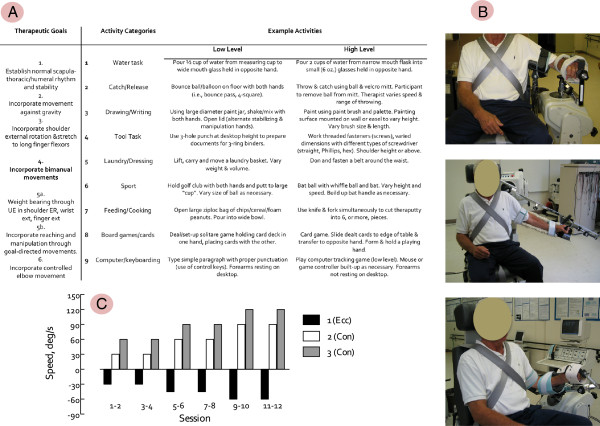
Therapeutic interventions. The therapeutic interventions used in this study included functional task practice (FTP) and upper-extremity power training combined with FTP (HYBRID). The structure of the FTP program is outlined in Panel A with examples of how activities were identified for study participants of varying abilities and progressed over the course of the intervention. Power training was delivered using a commercially available dynamometer fitted with custom attachments to enable non-standard positioning and accommodate individuals with impaired grasp. Pictured in Panel B are configurations for elbow flexion/extension (top), shoulder abduction (middle) and shoulder external rotation. The elbow flexion/extension configuration was also used for stretch reflex testing. Power training involved 3 sets of 10 repetitions of each exercise: shoulder flexion, shoulder abduction, shoulder external rotation, elbow flexion/extension. The criterion speeds for each set were varied using the protocol illustrated in Panel C. The first set of each exercise involved eccentric actions in which the participant resisted the dynamometer through the full range of motion. Using data reported by Colsen et al
[30] (see Figure
1) to estimate the power produced (i.e., torque x velocity) per contraction, the program was systematically progressed by increasing workload by 44% (Sessions 5-8 relative to 1-4) and 84% (Sessions 9-12 relative to 1-4).